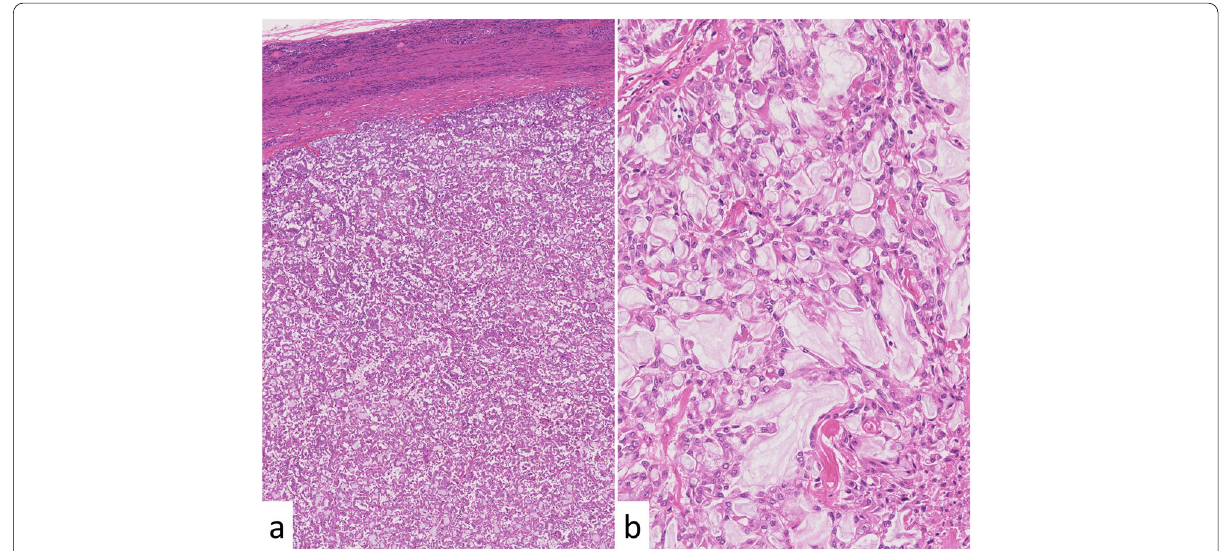
Fig. 2 Histological appearance. a : Low magnification ( High magnification (